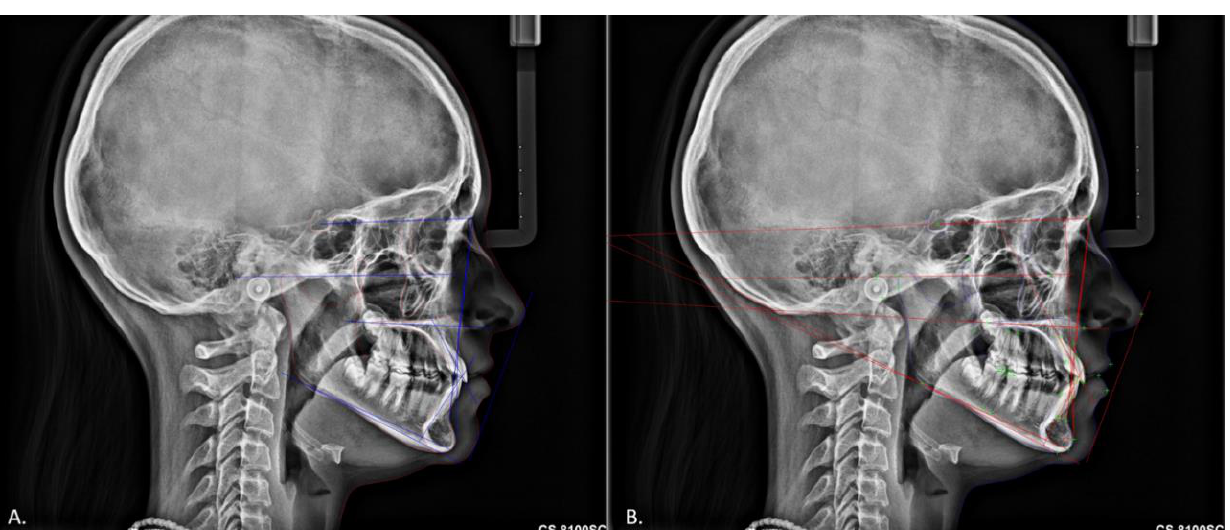
Table 1. Intraclass correlation coefficient (ICC) and 95% confidence interval (CI) for intra-method